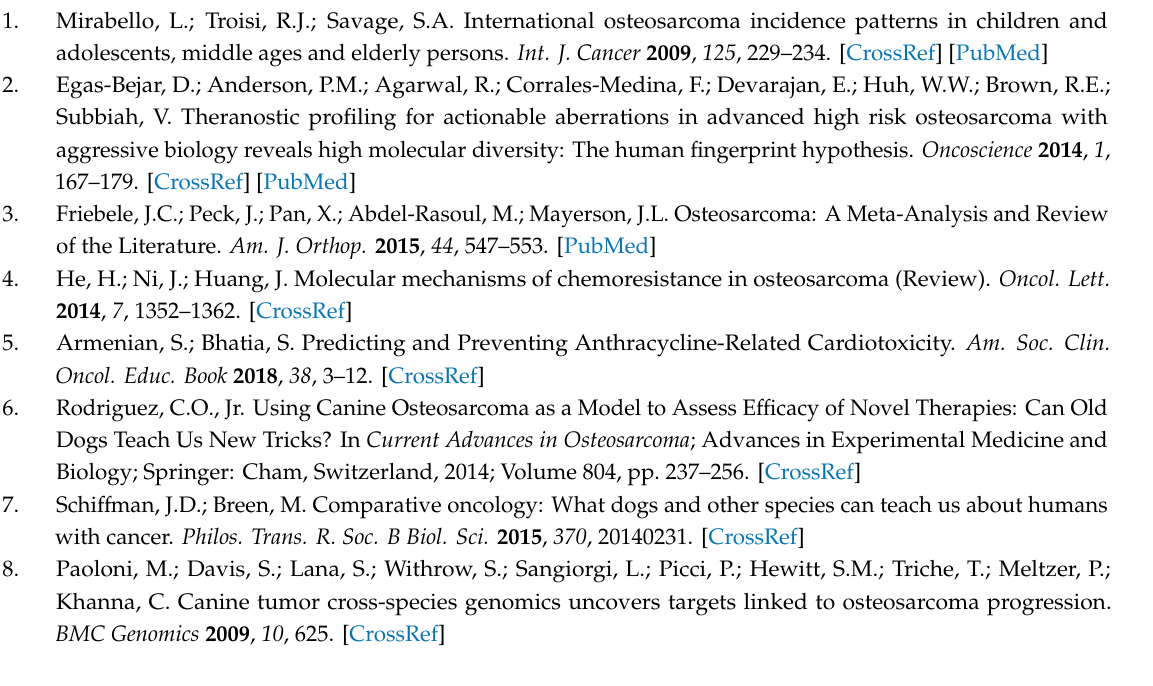
Figure S1: CRM1 upregulation is prognostic for poorer clinical outcomes in osteosarcomas, Table S1: Drug screen data for 17-3X and